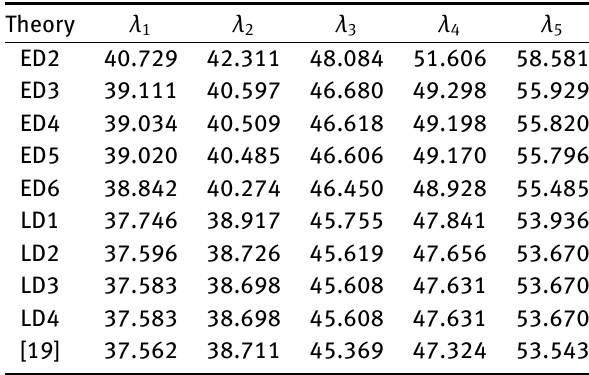
Table 3: Non-dimensional frequency parameters λ = ω ( a 2 / h ) of a [0/90] 3 CCCC cylindrical panel with a / h = 10 and a / R β = 2 .